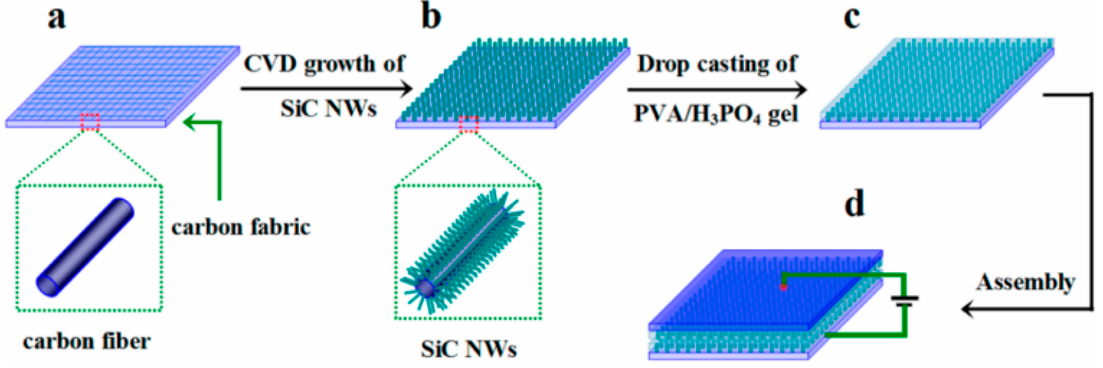
Figure 11. Overall synthesis process of SiC NWs@CF [107]. ( a, b, c , and d ) indicate carbon fiber paper, SiC NWs@CF, PVA/H3PO4@SiC NWs@CF, and symmetric device, respectively.